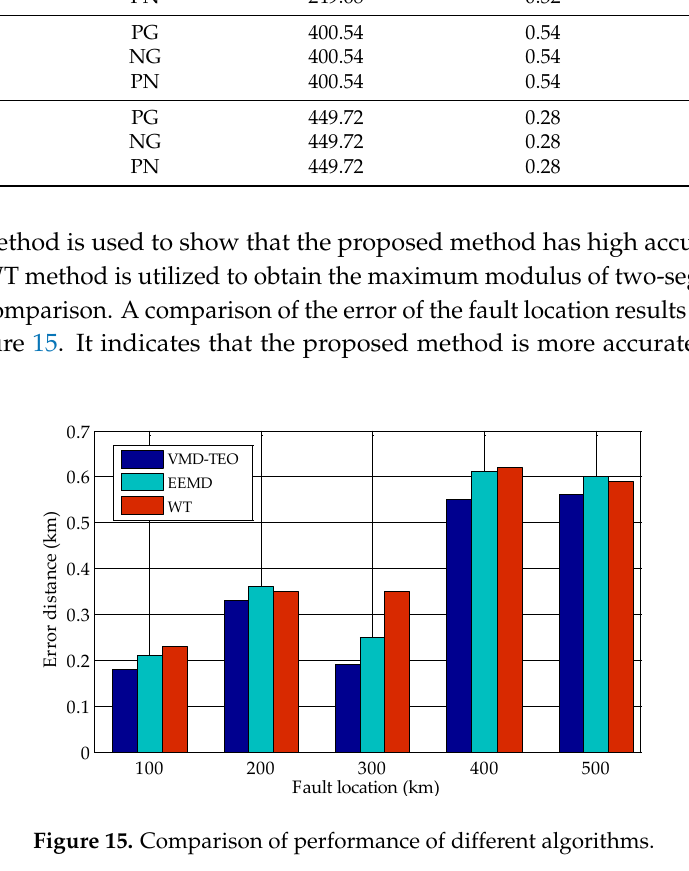
Figure 15. Comparison of performance of different algorithms.